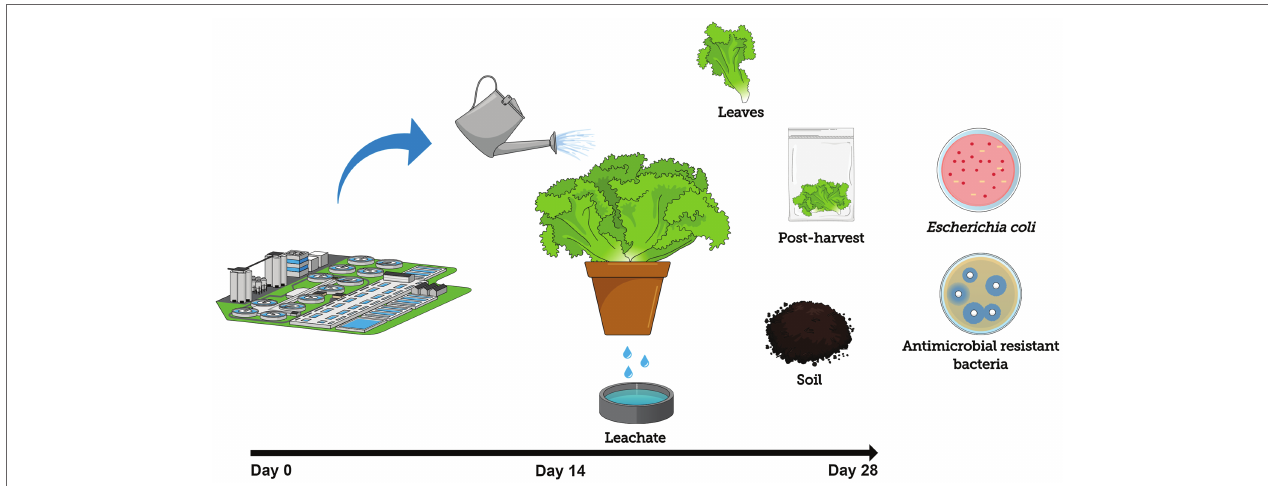
FIGURE 1 | Experimental design schematic showing lettuce cultivation using secondary-treated wastewater as irrigation source to track the fate and prevalence of Escherichia coli and antibiotic-resistant bacteria (ARB) throughout the entire system (foliage, soil, and leachate) during cultivation (14-day period) and post-harvest storage at 4 ° C (14-day